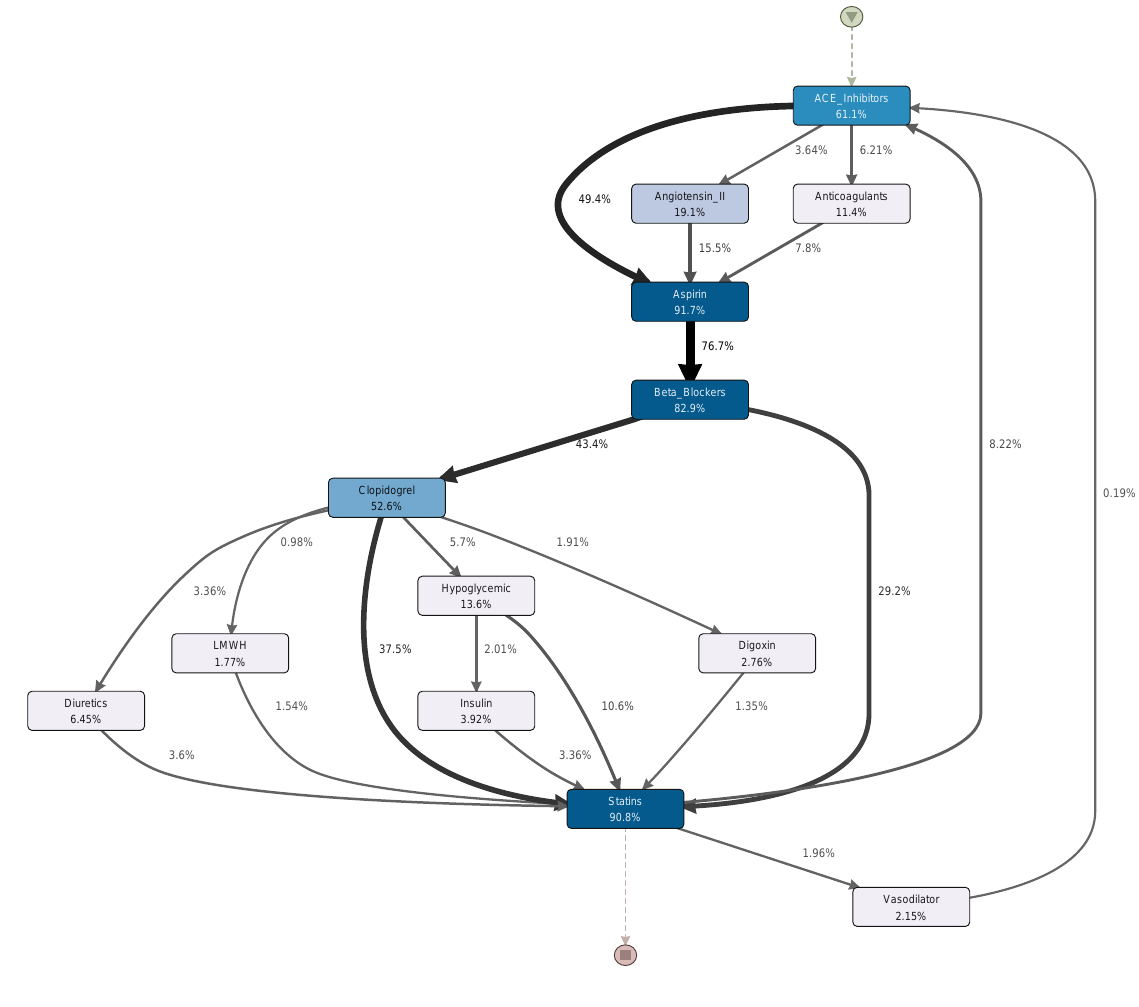
Figure 11. The process model discovered from the preprocessed event